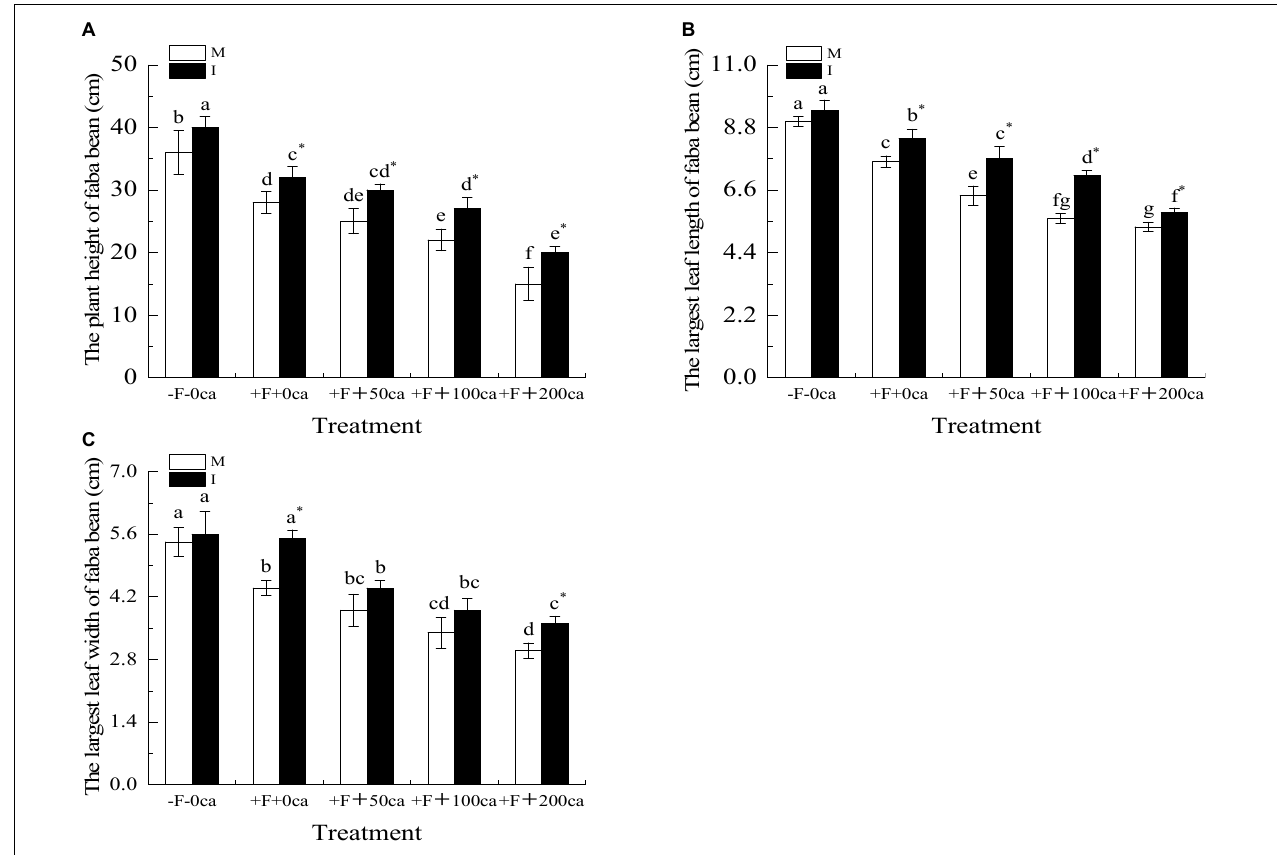
FIGURE 3 | Effects of FOF and cinnamic acid stress on the growth of faba bean ( Vicia faba ) and intercropping effect. (A) Plant height of faba bean, (B) The largest leaf length of faba bean, (C) The largest leaf width of faba bean. Values in this figure are the mean ± standard error. Different lowercase letters after the data indicate significant differences ( P < 0.05). ∗ significant differences between monocropping and intercropping treatments with the same FOF and cinnamic acid levels ( P < 0.05). ca, cinnamic acid, FOF, Fusarium oxysporum f. sp. fabae ; I, intercropping; M, monocropping.